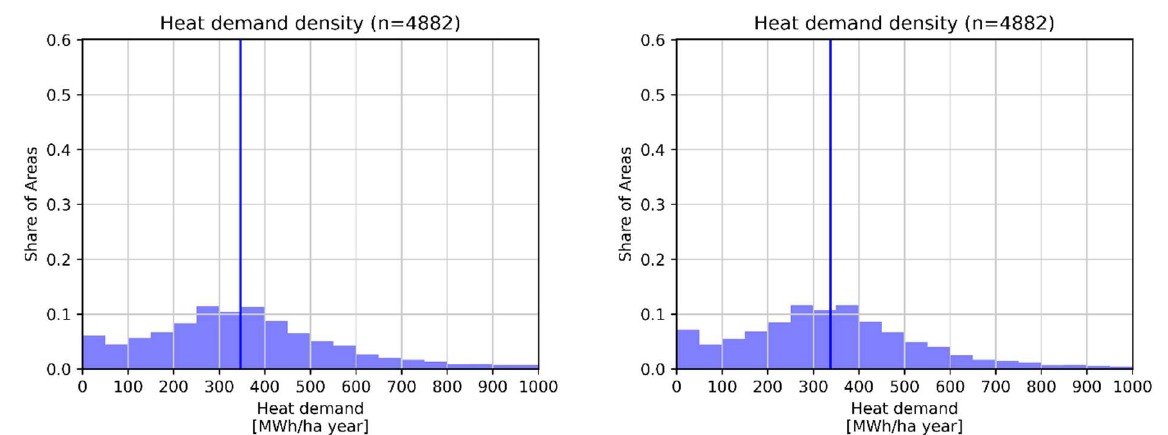
Figure 6. Frequency of small areas according to their heat demand density in Dublin weighted based on the number of areas ( left ) or the total floor area of the respective area ( right ). The vertical line indicates the median value.